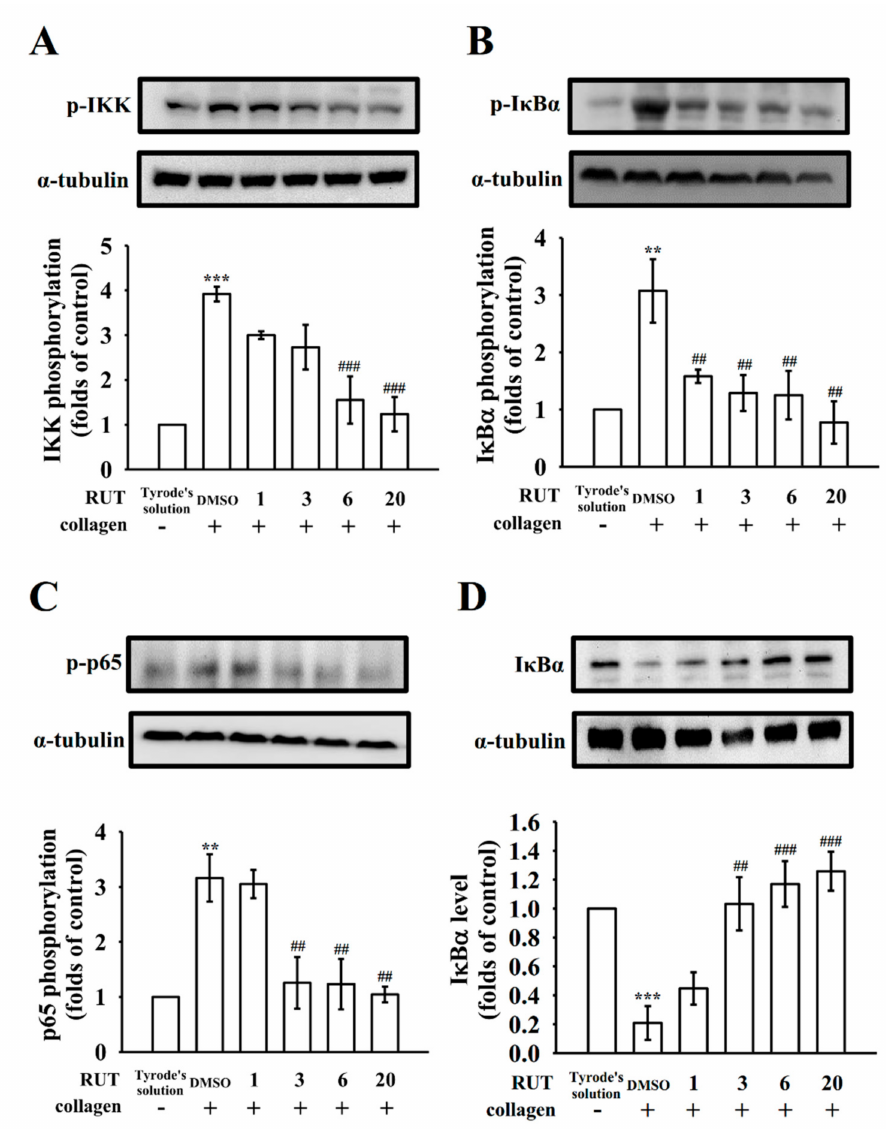
Figure 2. Effects of rutaecarpine on NF- κ B activation in platelets. Washed